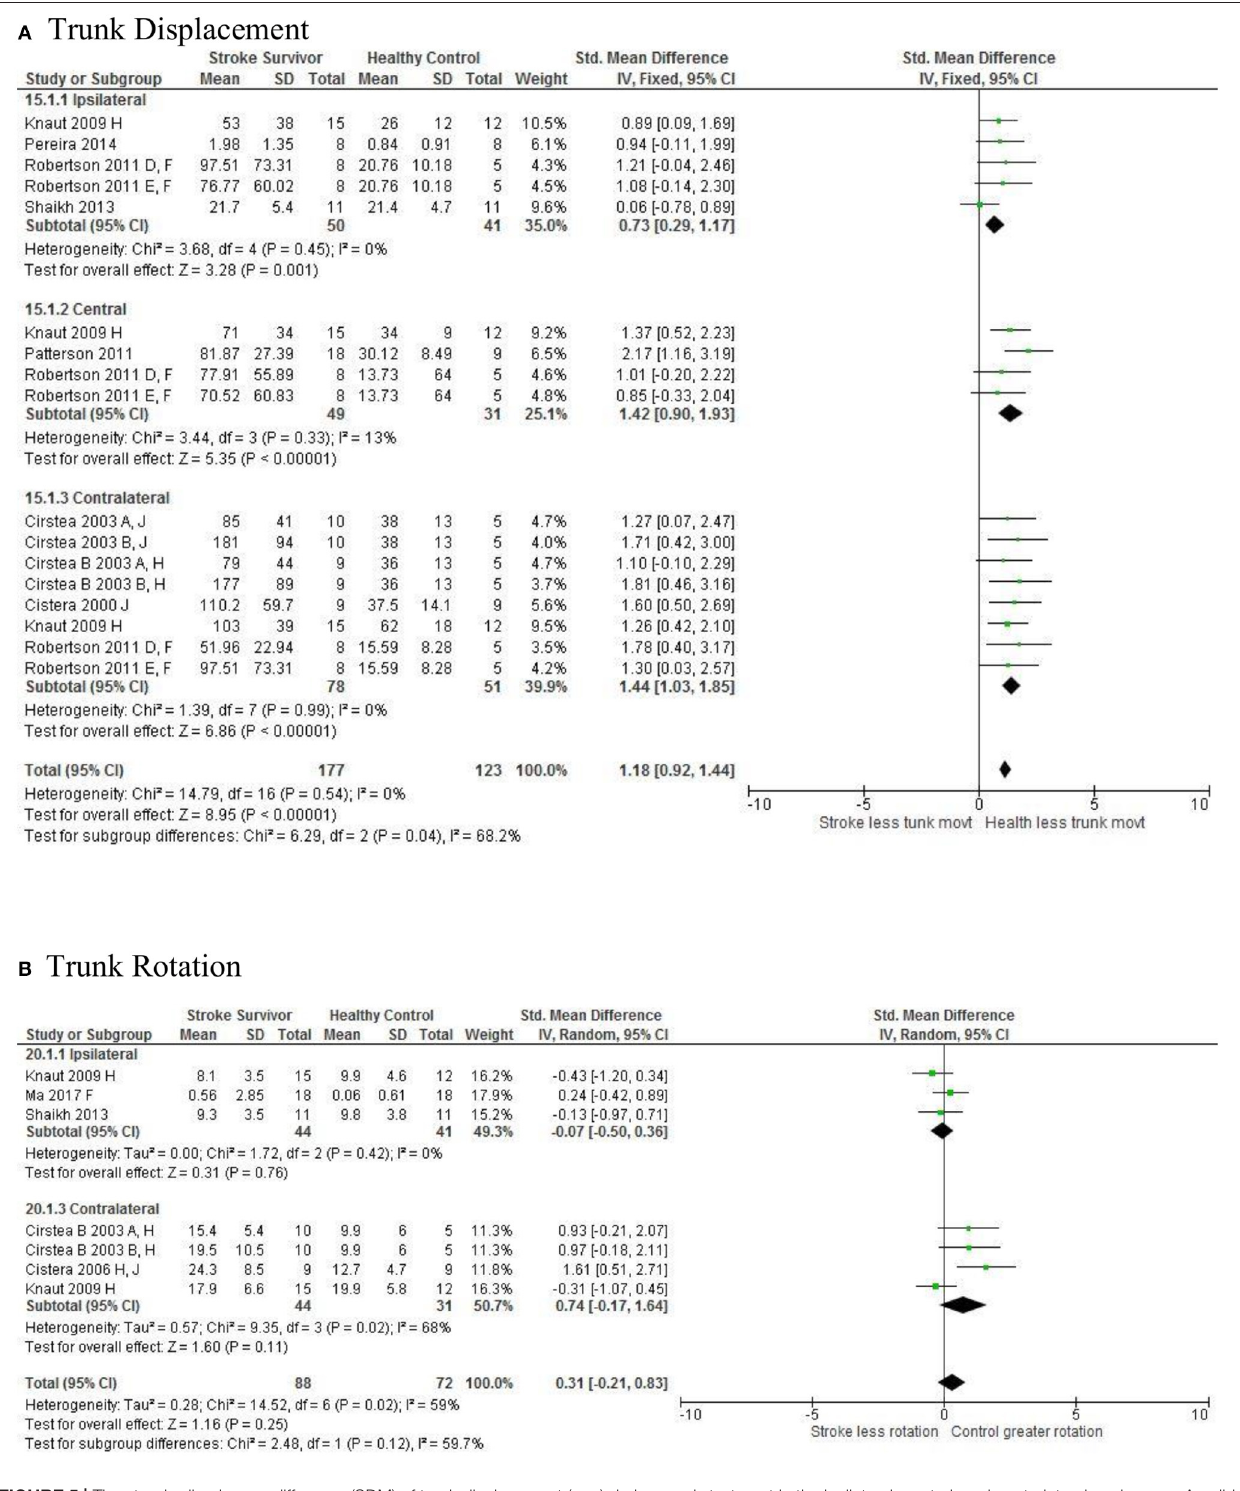
FIGURE 5 | The standardized mean difference (SDM) of trunk displacement (mm) during reach-to-target in the ipsilateral, central, and contralateral workspace. A, mild motor impairment; B, moderate motor impairment; C, bilateral task; D, right hemisphere stroke; E, left hemisphere stroke; F, target placed 90% of arm’s length; H, fast speed; LK robotics; J, reaches without